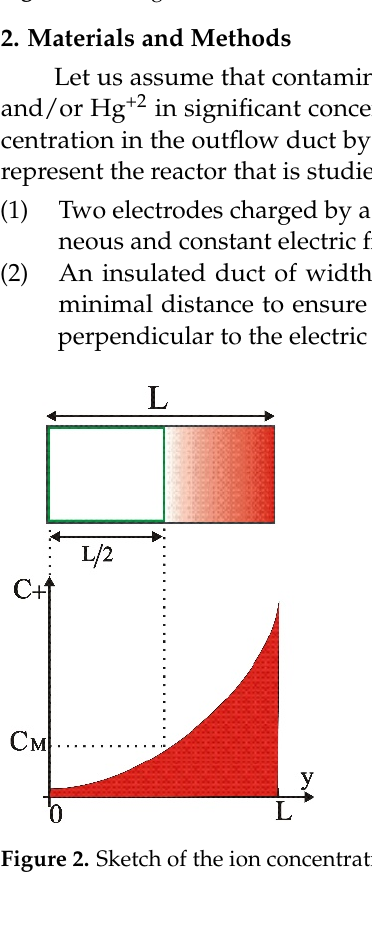
Figure 1. Configuration of the ion drift model.